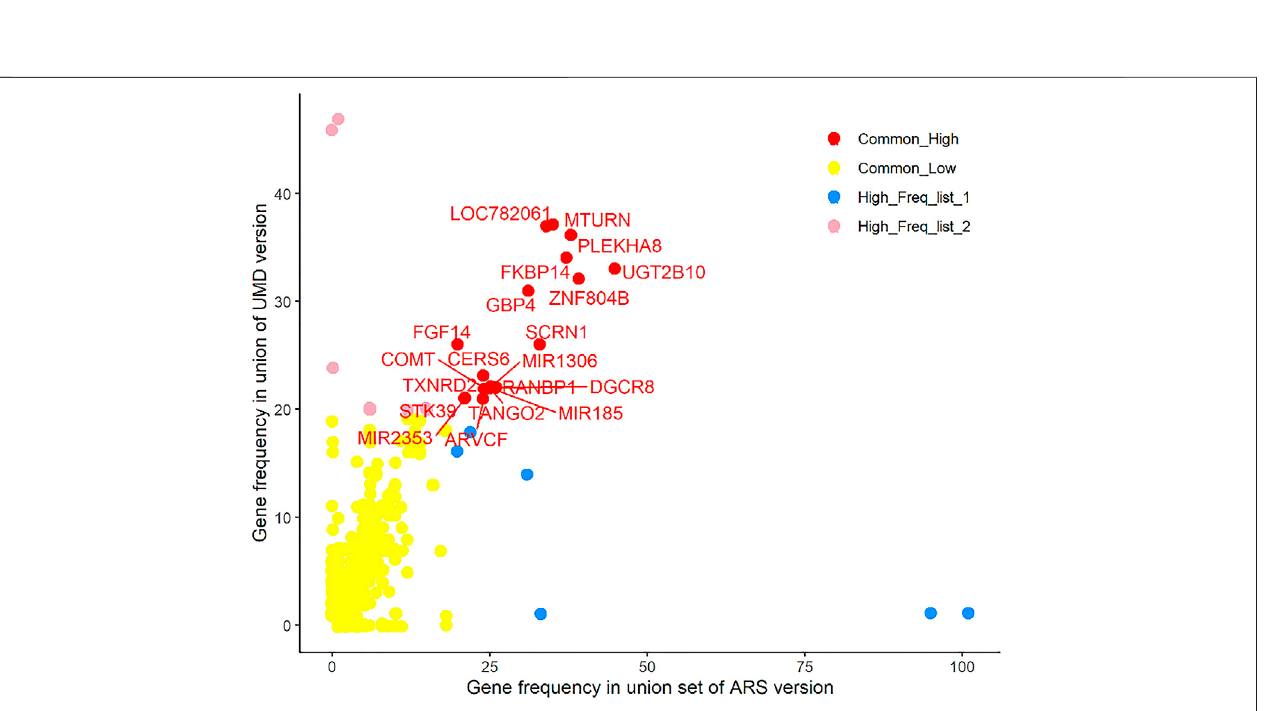
results more clearly. On the same reference genome, the